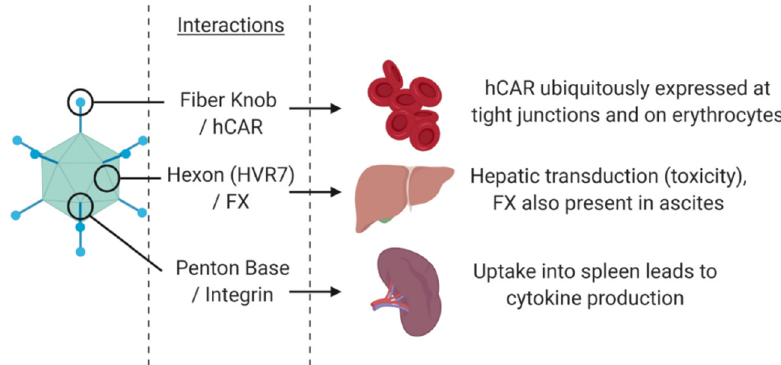
Figure 3. Dose-limiting Ad5 interactions in vivo. The fibre knob protein binds to hCAR expressed at tight junctions and on erythrocytes, the hexon binds to Factor X (FX) in the blood and the penton base binds to αvβ3/5 integrins. These binding interactions would lead to off-target effects. Created with BioRender.com.